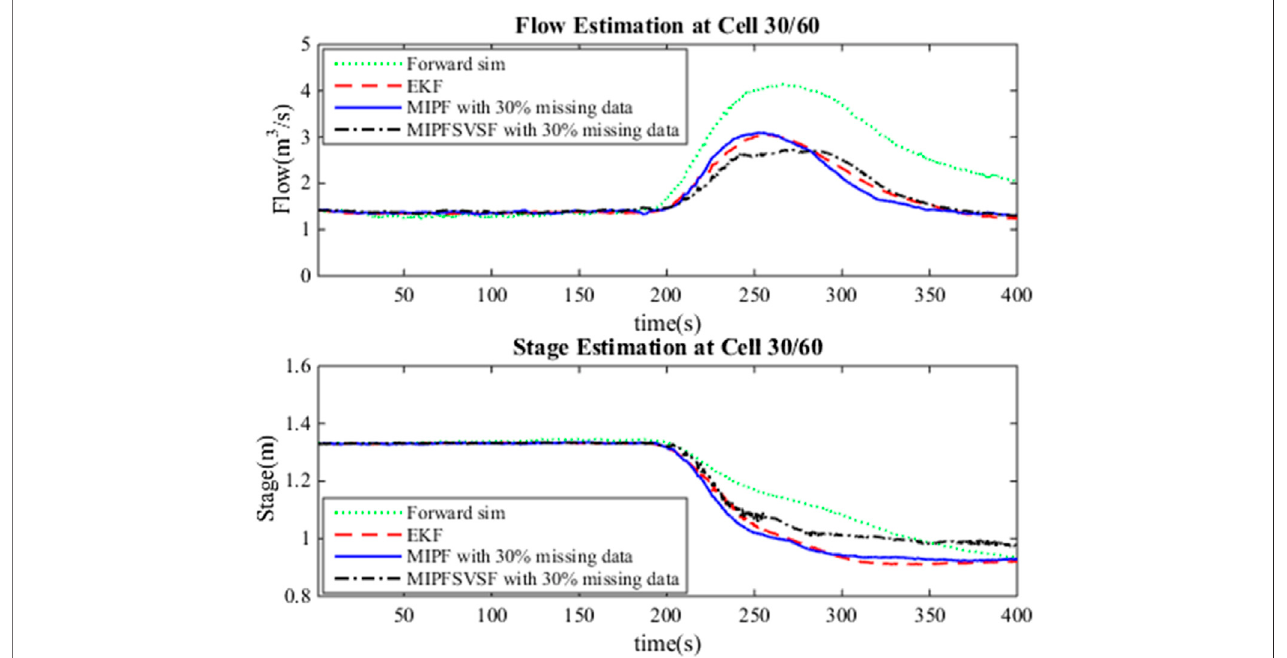
FIGURE 1 | Estimated fl ow and stage at the 30th cell, forward simulation, EKF during no missing data, MIPF with 30% missing data, and MIPF – SVSF with 30% missing data.